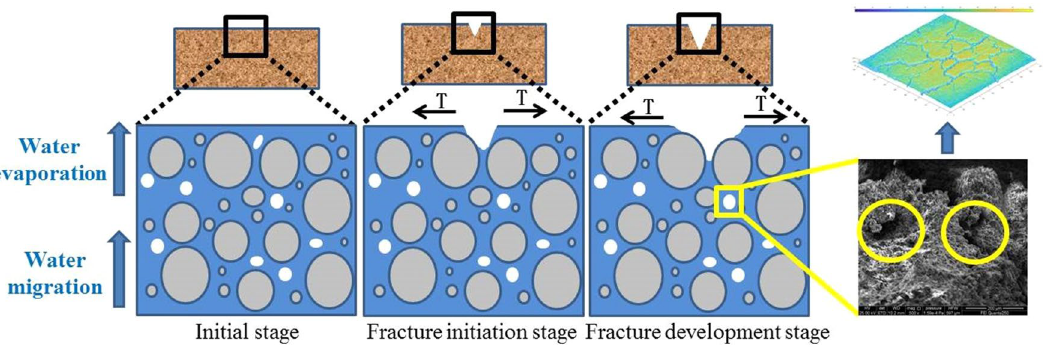
Figure 25. Schematic diagram of dry shrinkage cracking